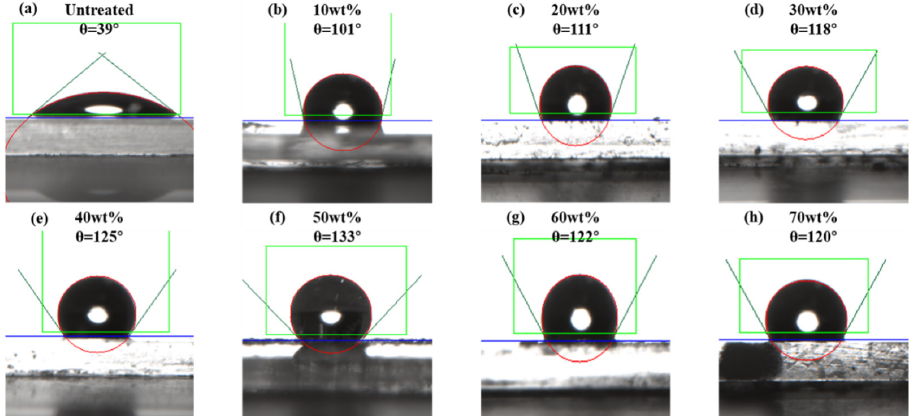
Figure 3. The contact angles on the glass sheets for different fluorinated monomer concentrations: ( a ) untreated glass sheet, ( b ) glass sheet treated with a fluorinated monomer concentration of 10 wt%, ( c ) glass sheet treated with a fluorinated monomer concentration of 20 wt%, ( d ) glass sheet treated with a fluorinated monomer concentration of 30 wt%, ( e ) glass sheet treated with a fluorinated monomer concentration of 40 wt%, ( f ) glass sheet treated with a fluorinated monomer concentration of 50 wt%, ( g ) glass sheet treated with a fluorinated monomer concentration of 60 wt%, and ( h ) glass sheet treated with a fluorinated monomer concentration of 70 wt%.